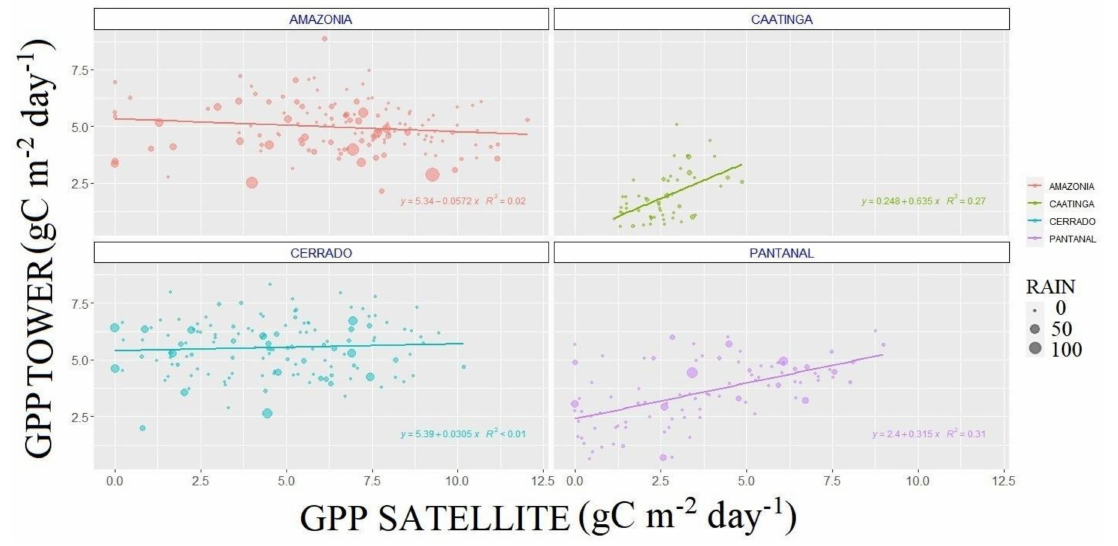
Figure 10. Correlation between daily tower GPP × MODIS GPP for each site. The size of the circles indicates the intensity of daily accumulated rainfall